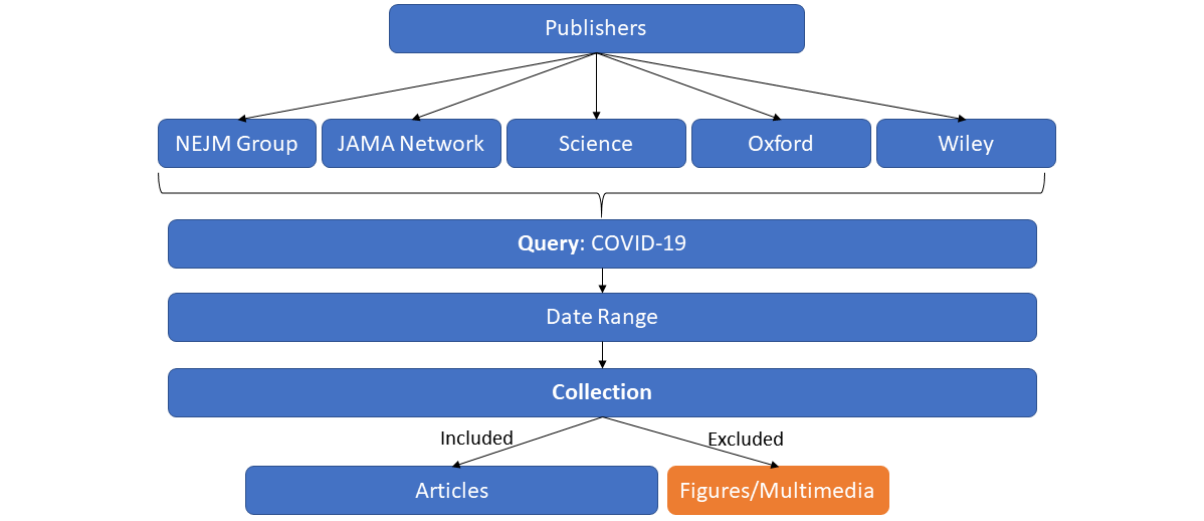
Figure 1. Publisher-wise searching for published research articles on COVID-19. NEJM: New England Journal of Medicine, JAMA: Journal of the American Medical